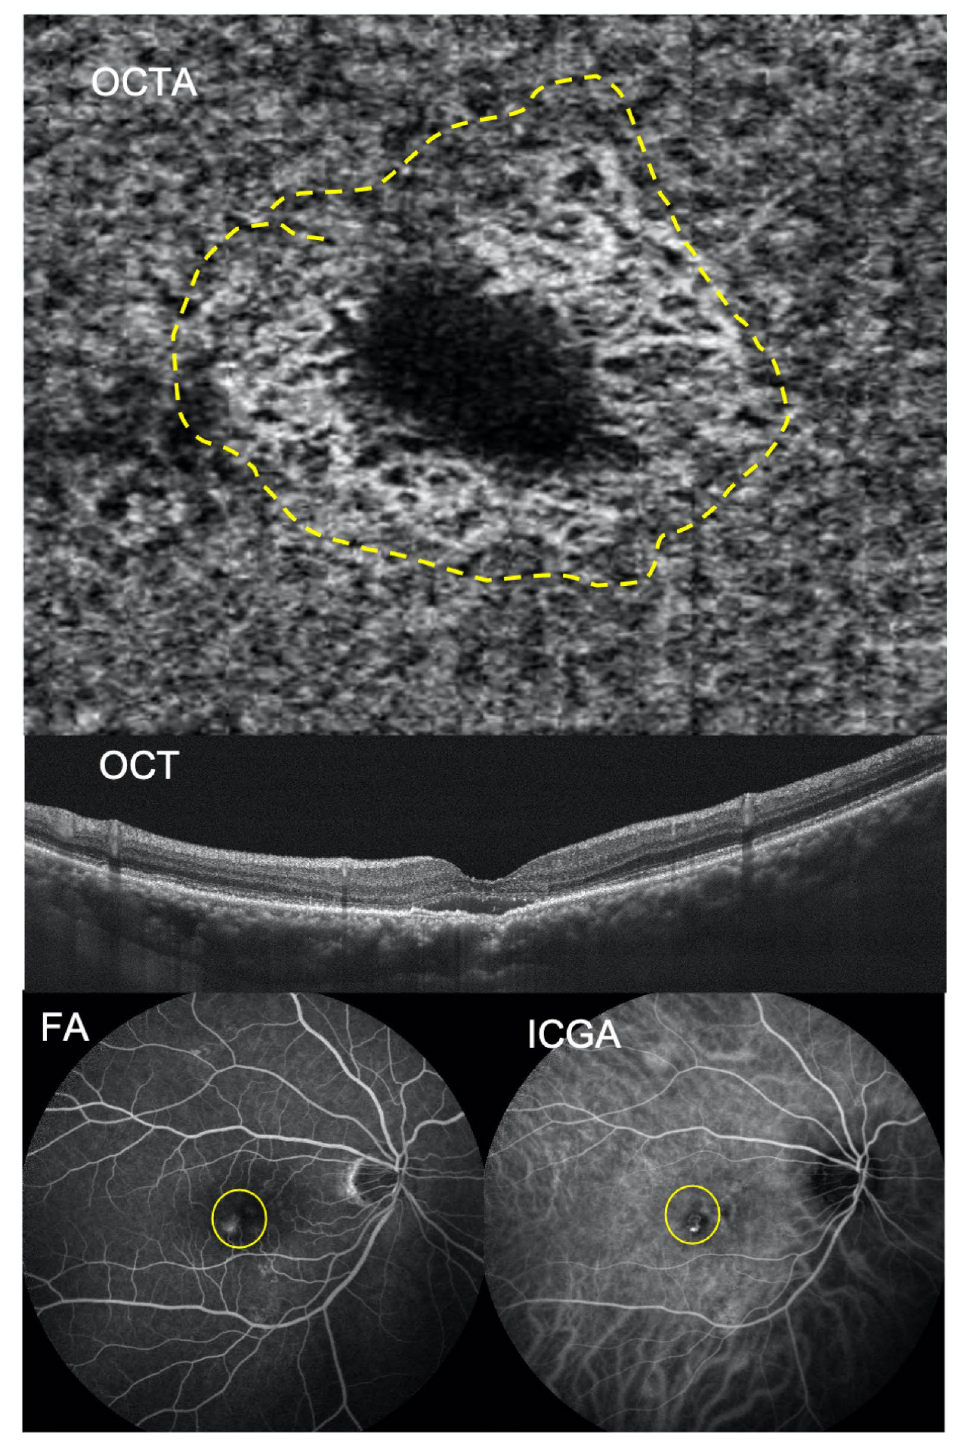
Figure 2. A 67-year-old male patient had type 2 BVN and type B PCV in the right eye. Baseline BCVA was 20/200. The OCTA image retrieved by AngioVue (RTVue XR Avanti, Optovue Inc., Fremont, CA, USA) showed prominent anastamoses of BVN which resembled nephrons (glomeruli form, highlighted by the dashed line), and RPED with SRF also existed. The SFCT was 275 μm. Both FA and ICGA images showed a cluster of BVN with definite feeding origin, but late leakage was not detected by FA (circle). BVN branching vascular network, PCV polypoidal choroidal vasculopathy, BCVA best-corrected visual acuity, FA fluorescent angiography, ICGA indocyanine green angiography, OCTA optical coherence tomography angiography, RPED: retinal pigment epithelial detachment, SRF subretinal fluid, SFCT subfoveal choroidal thickness, OCT optical coherence